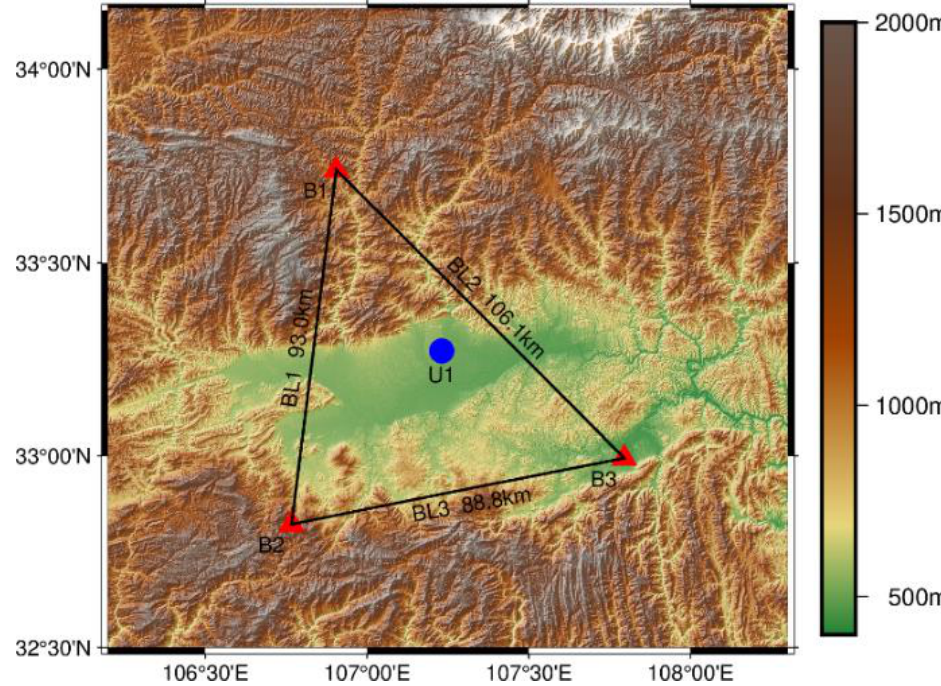
Figure 3. Distribution of first CORS (Continuously Operating Reference Stations) and user station.